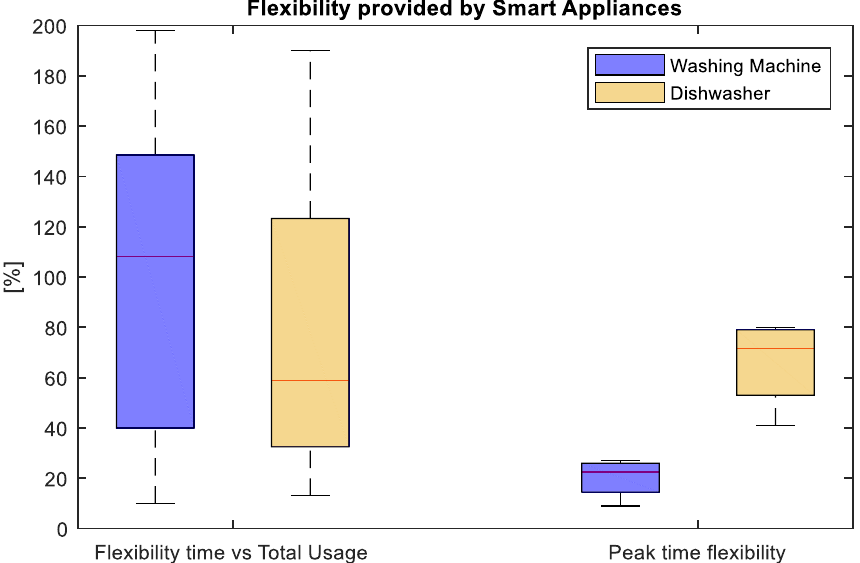
Figure 5. PowerMatching City smart washing machine and dishwasher. The latest run time program was compared to the actual use in 2012, shown as total flexibility time and flexibility offered during peak time.